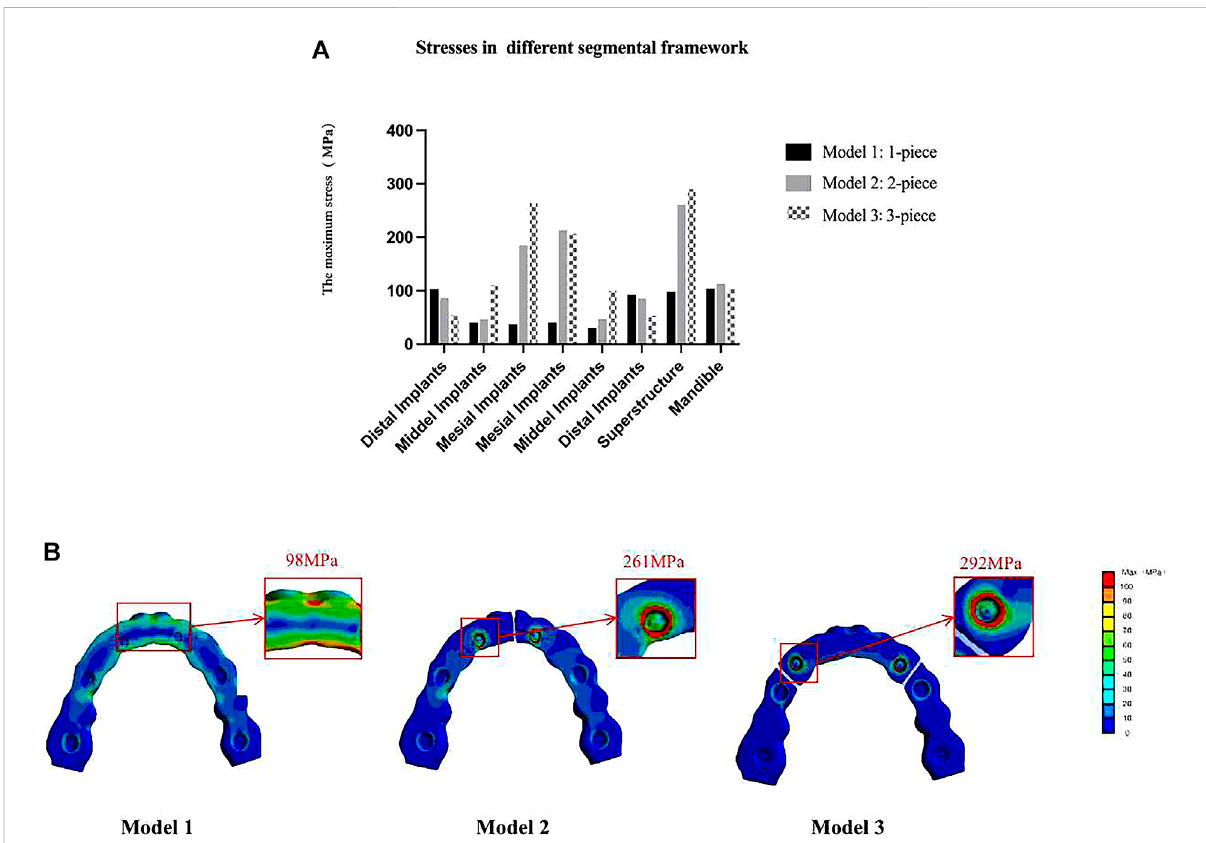
FIGURE 8 Von Mises maximum stress values (A) and pseudo-color stress distribution (B) in different segmental prosthetic frameworks of the mesofacial type/male.Intheone-pieceframework prosthesis, thelargestbonestressoccurred arounddistalimplantsandthemid-lineofthesuperstructure.In the two-piece and three-piece framework prostheses, stress was mostly signi fi cantly concentrated at the joint between the abutments and superstructure (42 – 32, 33 – 34, and 43 –